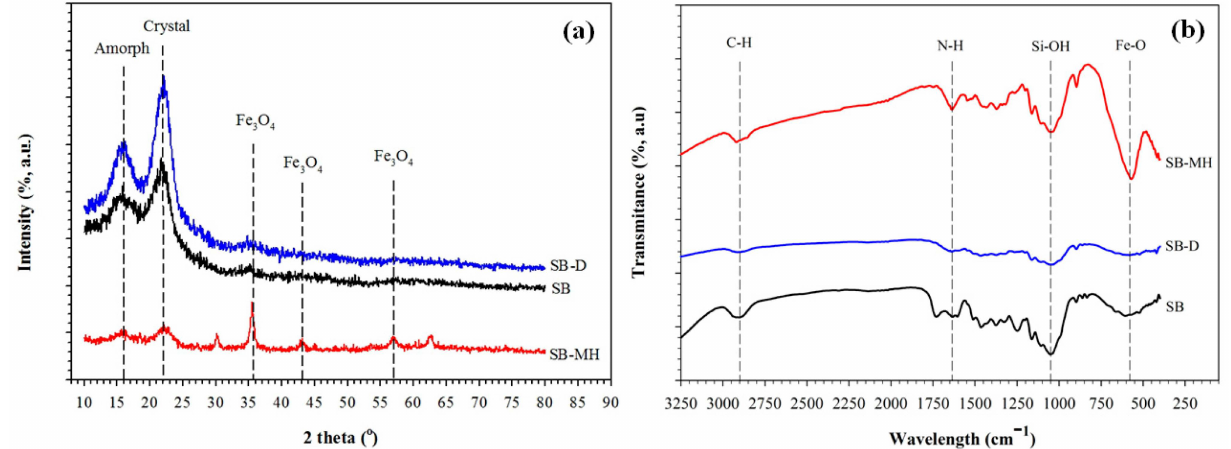
Figure 2. ( a ) X-Ray Diffraction (XRD) pattern and ( b ) FT-IR spectrum of sugarcane bagasse (SB), SB after delignification (SB-D) and biocomposites of amine magnetic sugarcane bagasse